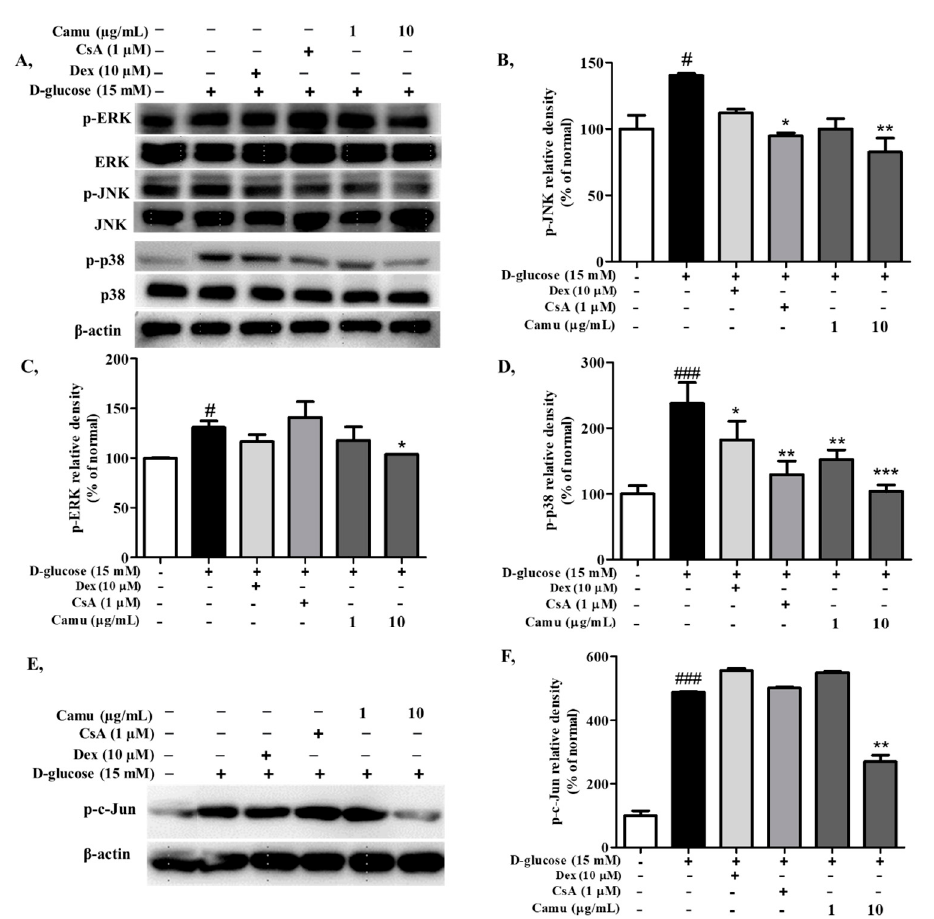
Figure 4. Effects of the camu-camu fruit on the MAPK/AP-1 signaling pathways in high glucose-stimulated HaCaT cells. JNK, p38, ERK, and their phosphorylation were analyzed by Western blotting ( A ). Phosphorylation of c-Jun was assessed by the Western blot analysis ( E ). Band intensities for p ‐ JNK ( B ), p ‐ ERK ( C ), p ‐ p38 ( D ), and p ‐ c ‐ Jun ( F ) were measured by densitometry and normalized; the percentage was calculated on the basis of the level of β‐ actin. The data are shown as the means ± SD of three independent experiments. # Significant differences between the untreated group and the high glucose ‐ induced group (# p < 0.05; ### p < 0.001). * Significant differences between the high glucose ‐ induced group and the other groups (* p < 0.05; ** p < 0.01; *** p < 0.001).